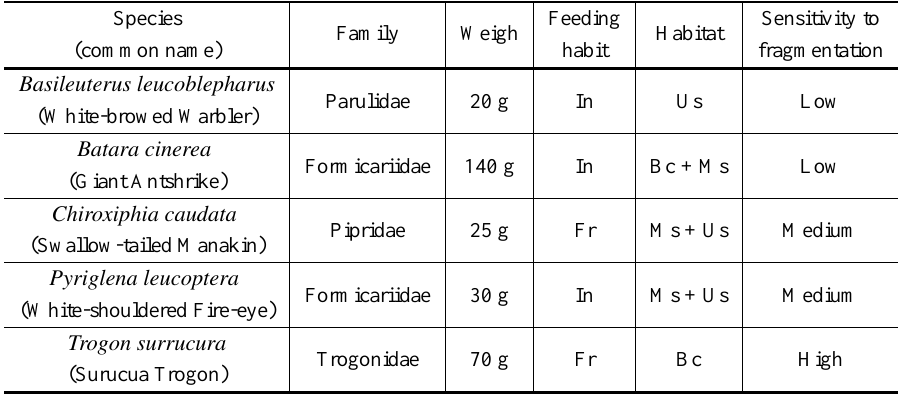
Selected bird species and their characteristics. In: insectivorous; Fr: frugivorous; Bc: below canopy; Ms: middle storey; Us: understorey. Species Feeding Family Weigh